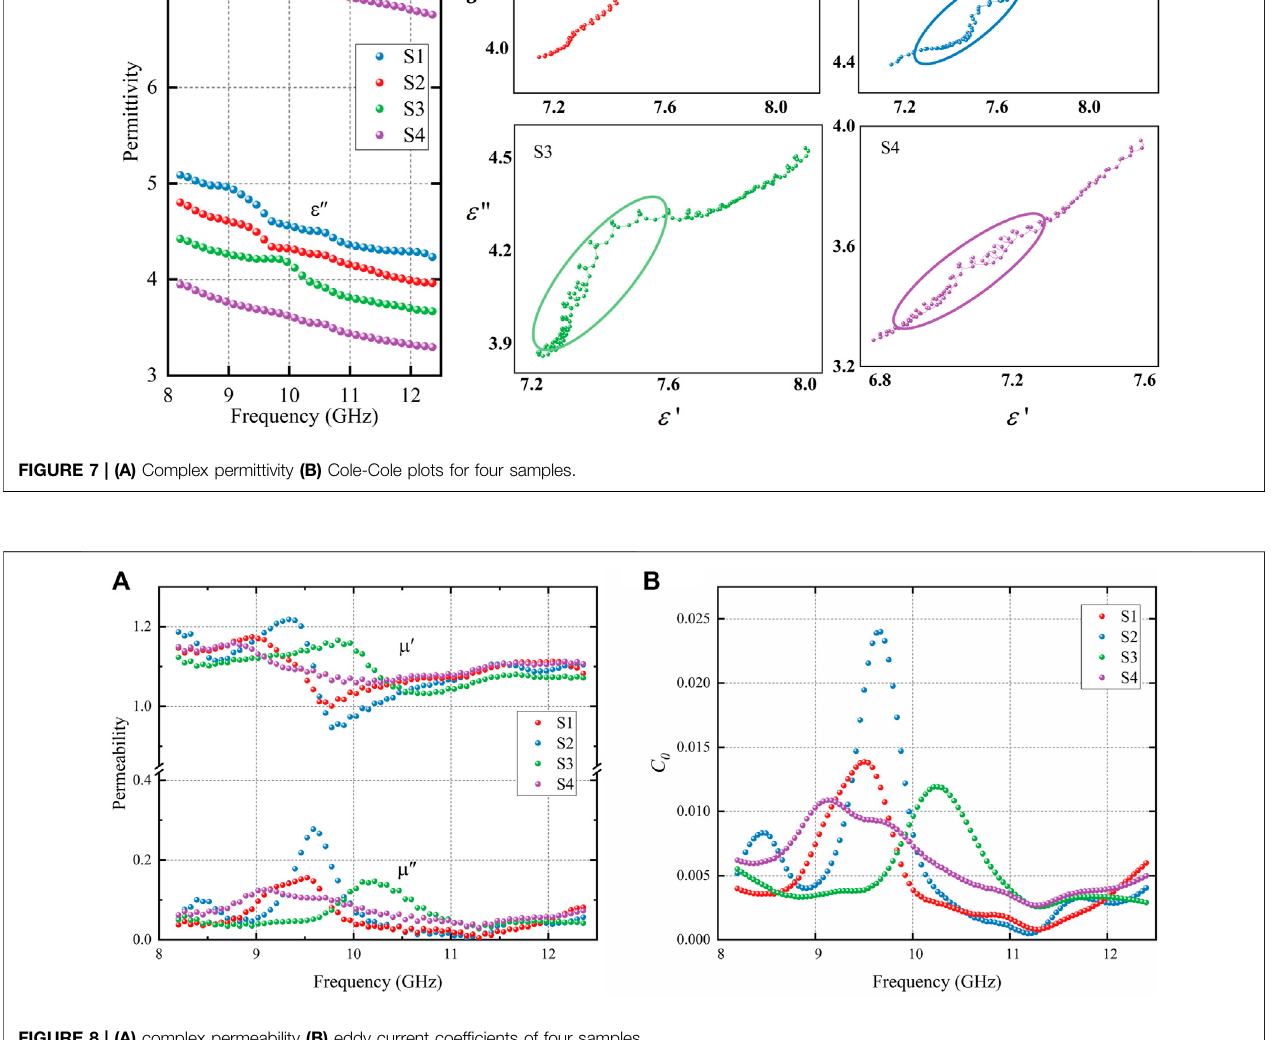
Frontiers in Materials |